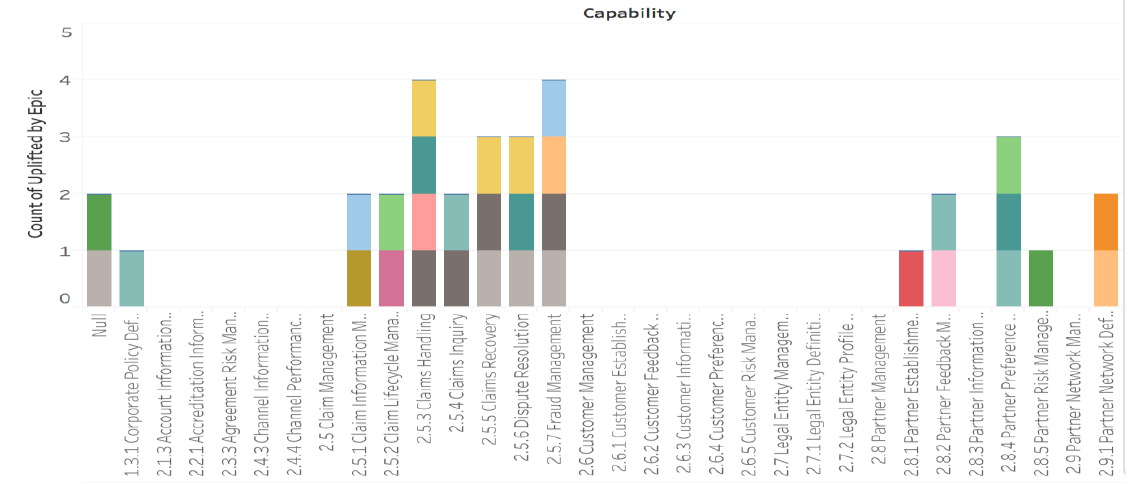
Figure 12. Capability Gap analysis